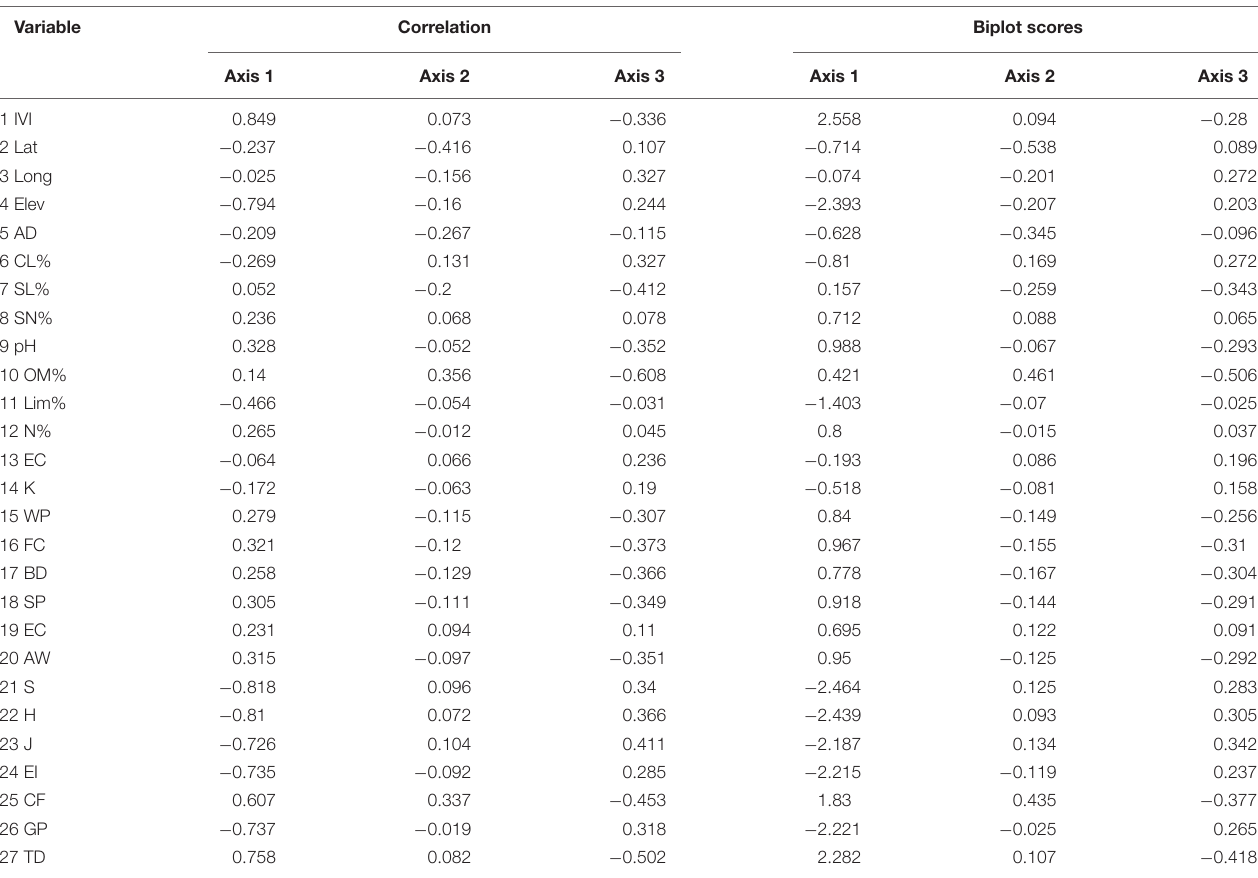
TABLE 4 | Correlation and biplot scores extracted from redundancy analysis of the associated environmental variables operated on S. marianum plant functional traits (PFTs). Variable Correlation Biplot